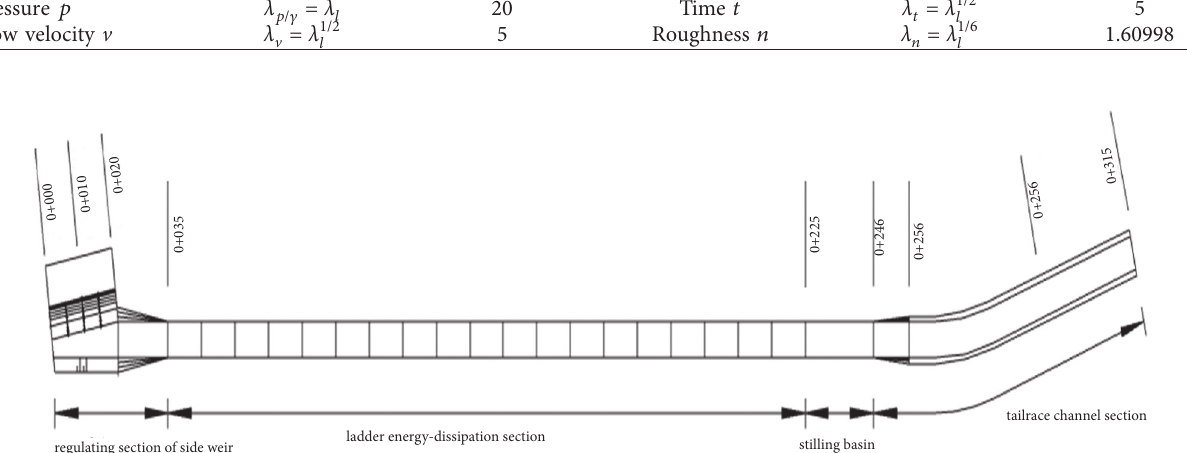
Figure 2: Plan view of the model.